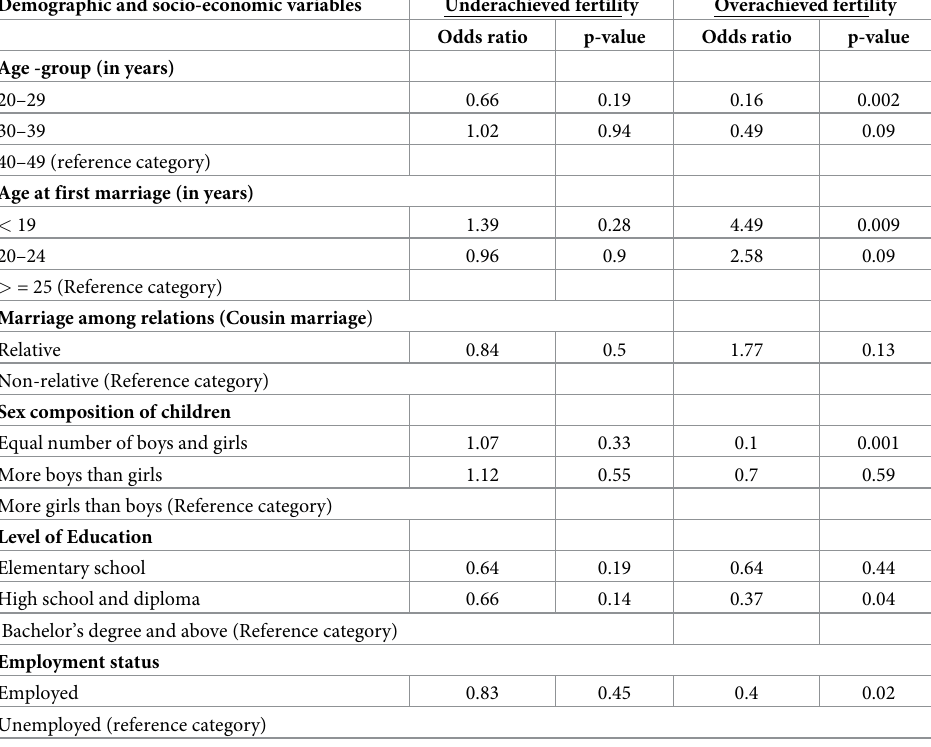
Table 8. Odds of under-achieving or over-achieving fertility with reference to achieved fertility according to demographic and socio-economic variables. Demographic and socio-economic